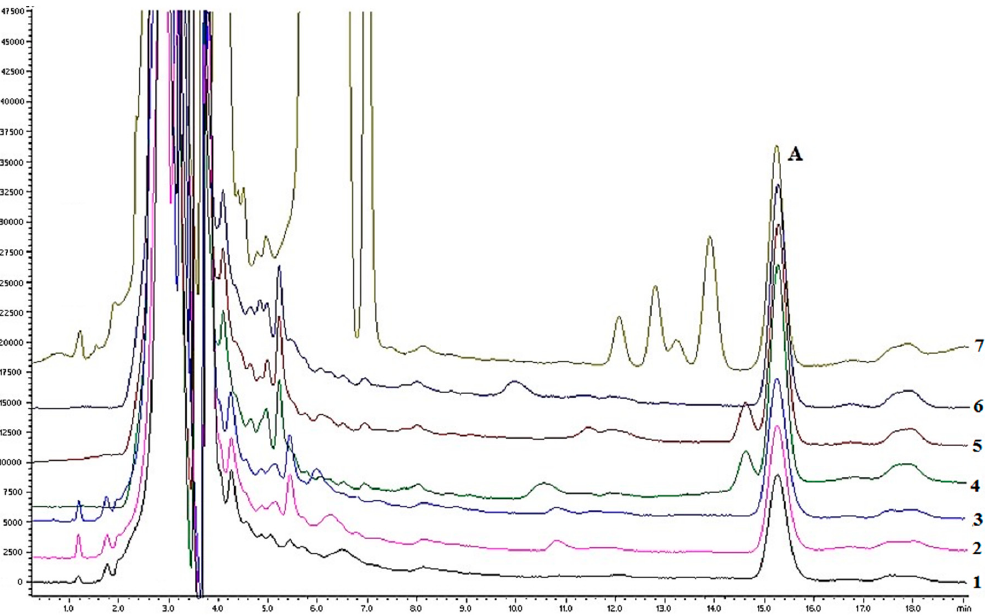
Figure 2. Chromatograms of extracts, capsules, and syrup (A-hederacoside C, 1–3 extracts (three different series), 4–6 capsules (three different series), 7 syrup).